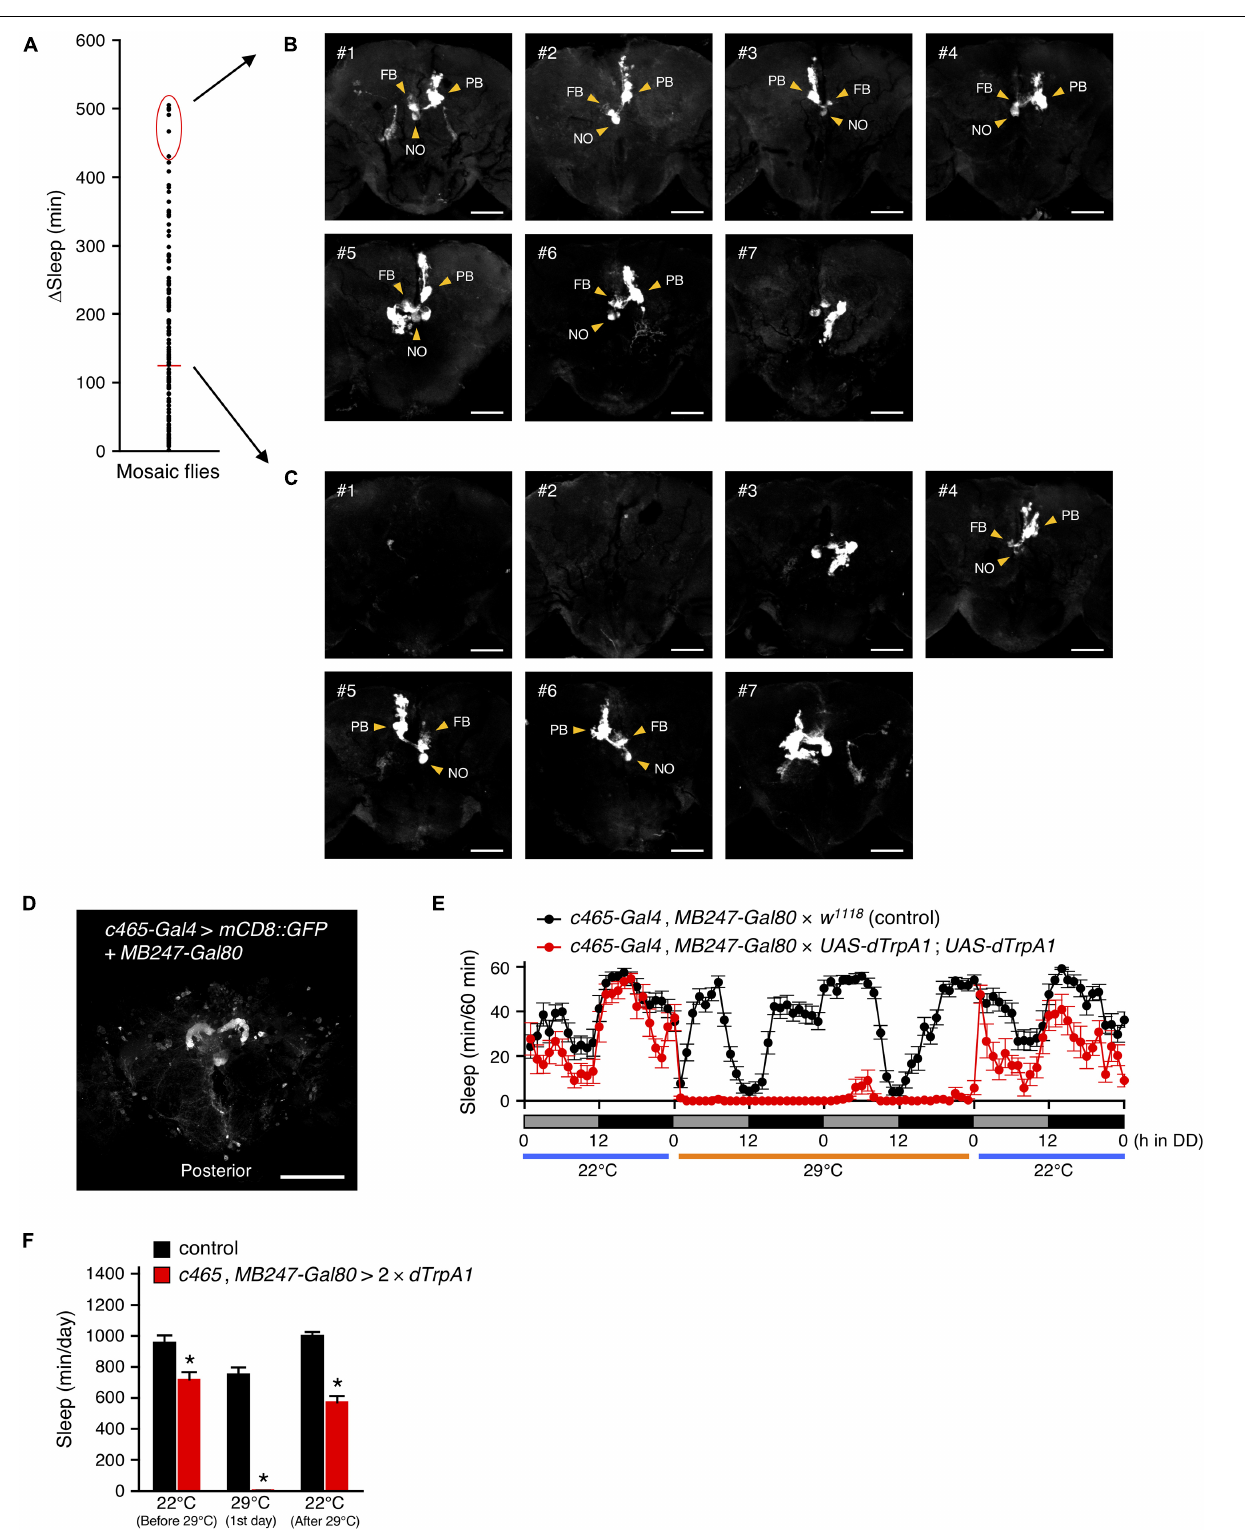
FIGURE 5 | R52B10-Gal4 -expressing PFN neurons promote wakefulness. (A) Using the MARCM system, dTrpA1 expression was targeted to a limited number of neurons in R52B10-Gal4 . The behavior of mosaic flies was monitored as described in Figure 2 . Sleep change ( (cid:49) Sleep) of a single fly was calculated by